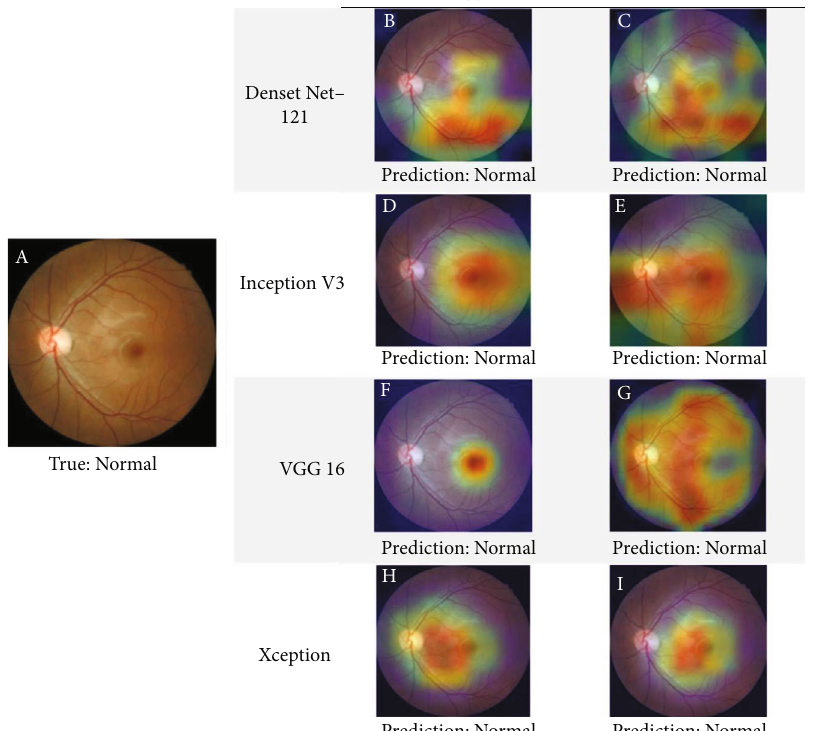
Figure 5: The images present the original (a) and superimposed Grad-CAM activation maps ((b) – (i)) of the selected normal color fundus image. All models gave a true-negative prediction. There was a high variation in the activation map when given a normal fundus image. Some models focus on the optic disc ((e) and (g)), whereas others highlight the retinal vessels ((b), (c), and (g)), or macular region ((d), (h), (f), and